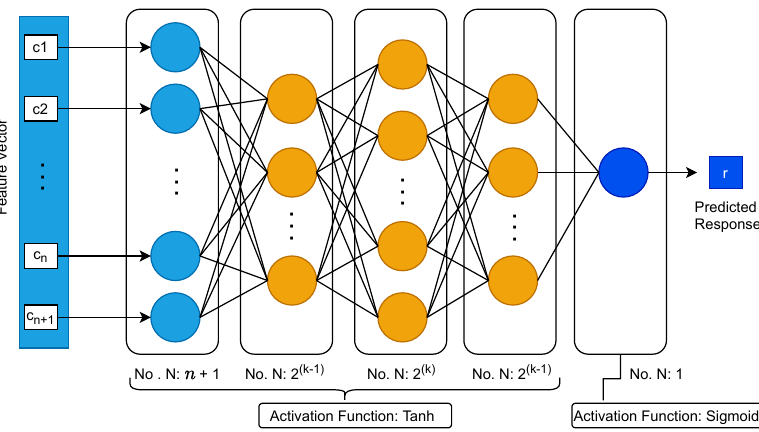
Figure 6. Illustrating the MLP structure proposed by Mursi et al. in [15]. Table 3. Hyper-parameters set for the initialization